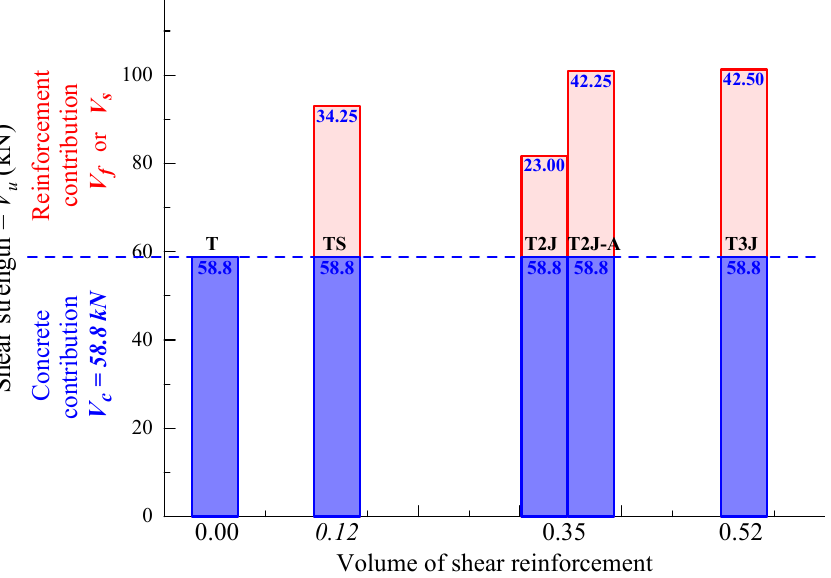
Figure 5. Concrete and fiber-reinforced polymer (FRP) contribution in shear strength. Table 2. Effect of FRP sheets on the shear strength.